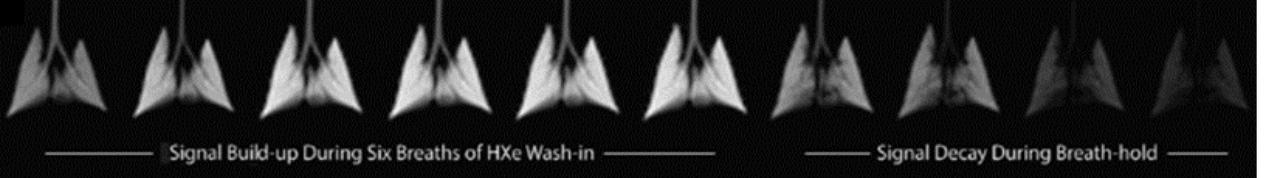
Figure 5. A series of 6 wash-in breaths of 70%/30% HXe/O 2 is followed by four images acquired over a 12-second breath hold in a horizontal slice in a healthy rabbit. Washin dynamics illustrate the uniformity of signal buildup arising from uniform ventilatory gas exchange efficiency characteristic of health. Images acquired at breath-hold show some shrinkage of the lung as xenon is taken up into